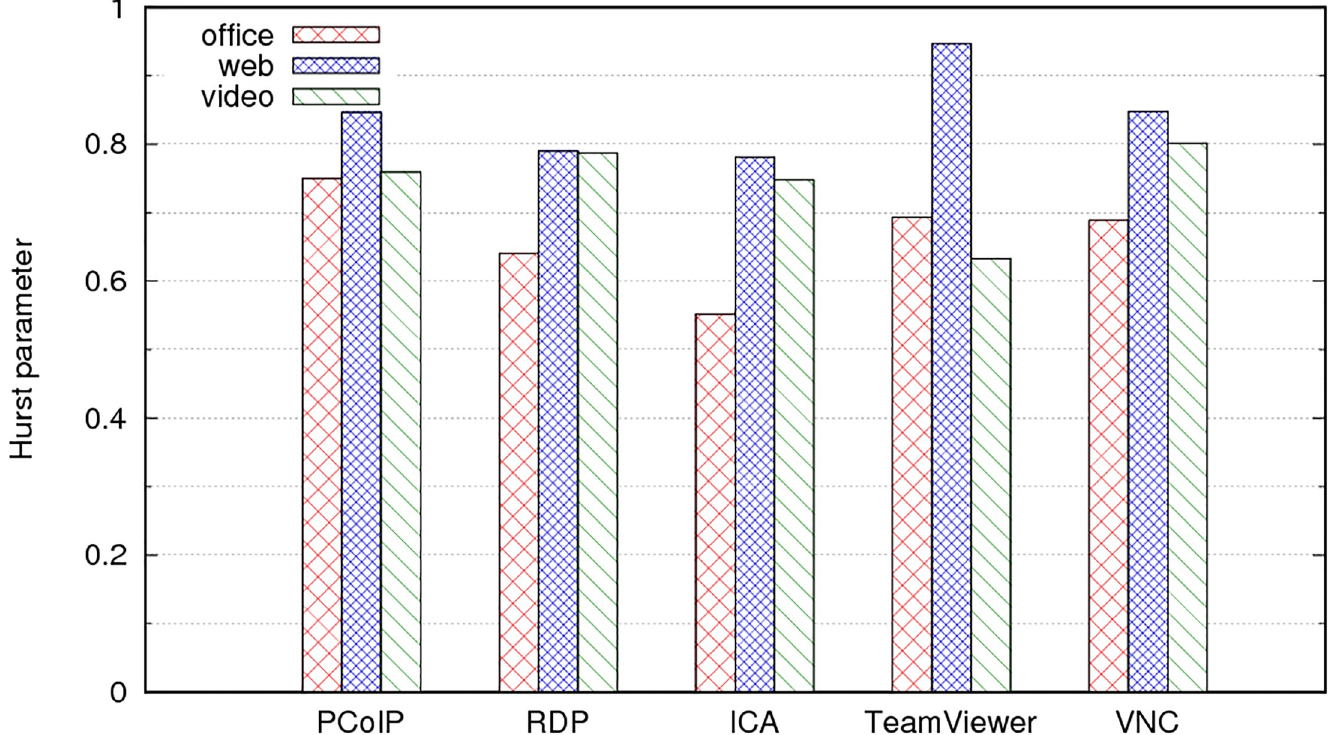
Fig 13. Values of H for different remote desktop protocols and user